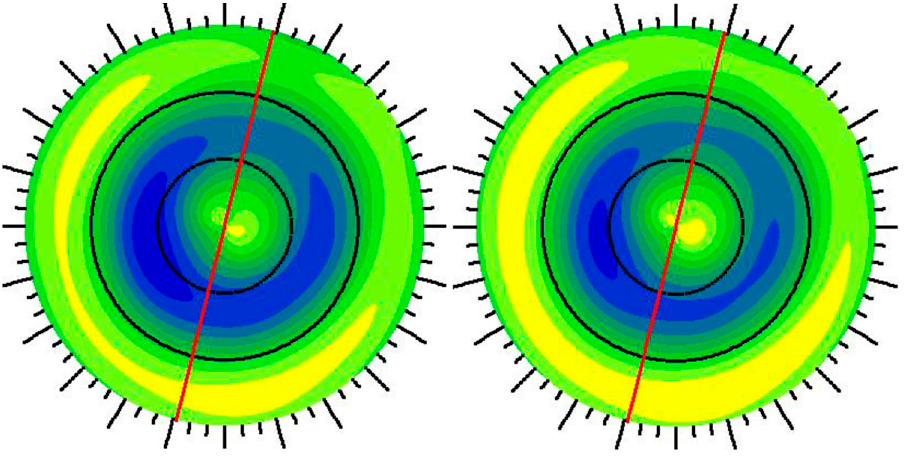
Figure 6. Axial corneal curvature maps (Diopters) for post-PRK ( left ) and post-LASIK models ( right ).